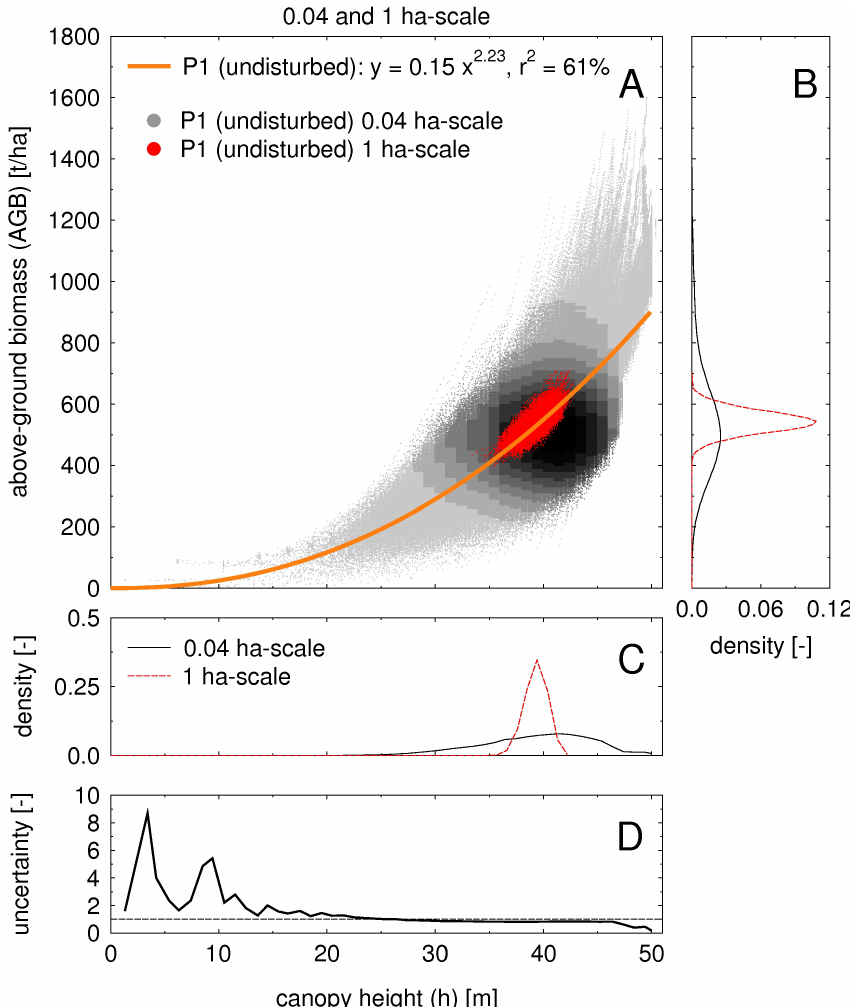
Fig. 1. Relation between above-ground life biomass (AGB) and canopy height ( h ) for the undisturbed forest (site P1). (A) Data on 0.04ha- scale (grey to black) (red: 1ha-scale for comparison) are plotted together with a power-law regression function. Due to the huge number of data points in the scatter plot of the 0.04ha-scale (more than 1000000) the grey-scale indicates the density of the data points with highest densities in black. Normalised density of (B) AGB and of (C) h for both spatial scales. Legend in C as in B. (D) Relative uncertainty (4 σ /mean) of the 95% confidence interval, dotted horizontal line marks